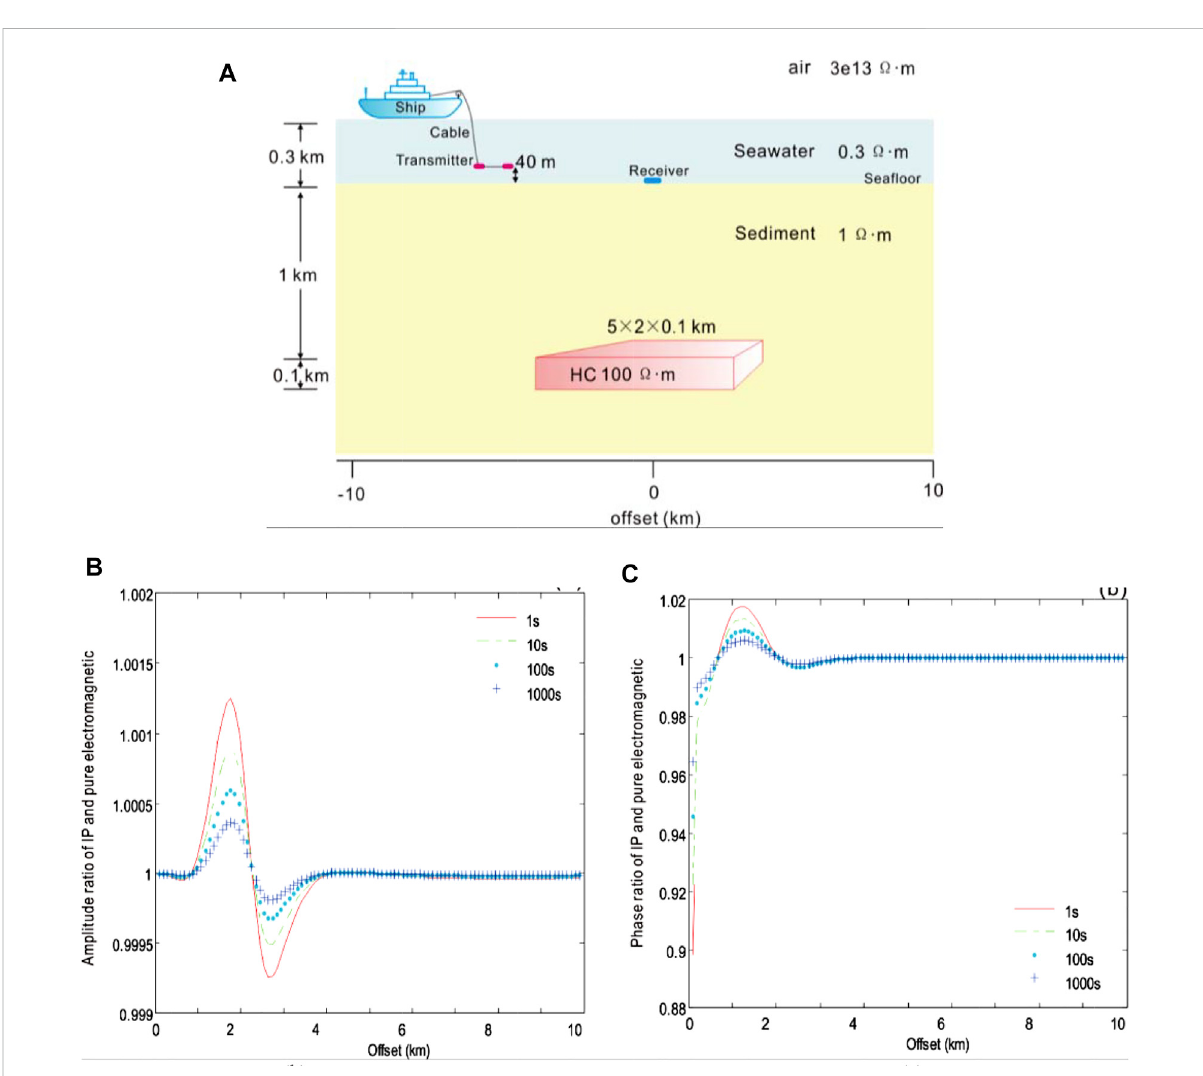
FIGURE 6 Amplitude and phase ratio of CSEM with the IP and pure electromagnetic fi eld to the Cole – Cole model of various time constants τ = 1 (red), 10 (green), 100 (blue), and 1,000 (light blue), respectively. (A) Geoelectric model of submarine hydrocarbons with ion-induced polarization in the 3D marine CSEM, (B) the ratio of amplitude, and (C) the ratio of